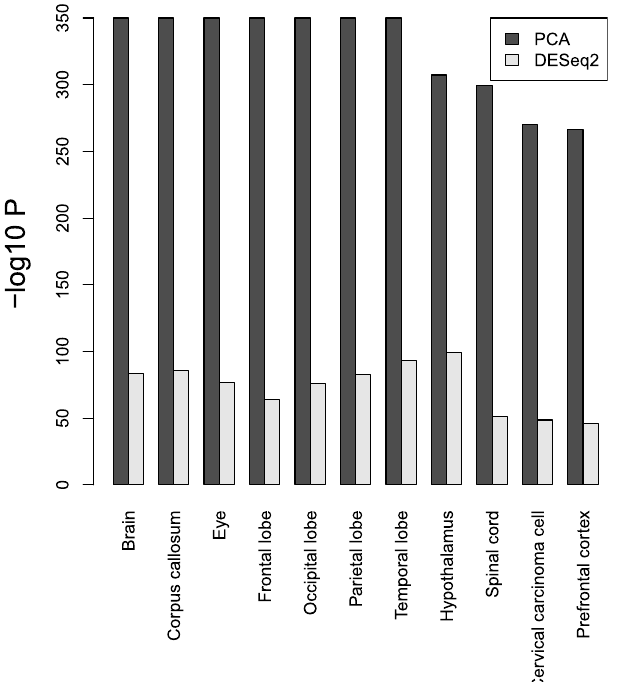
Figure 12. Enrichment analysis of the selected genes, whose numbers in Table 3 P values are adjusted P values (based upon “Jensen Tissues” category in Enrichr). Seven terms associated with − log 10 P = 350 are linked with ∞ , since P = 0 .